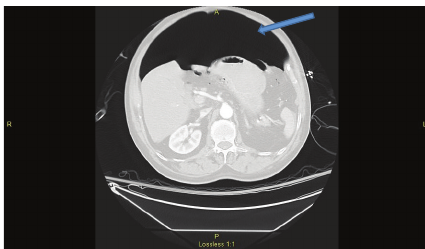
Figure 2: CT scan of abdomen showing large amount of air in the abdominal cavity.